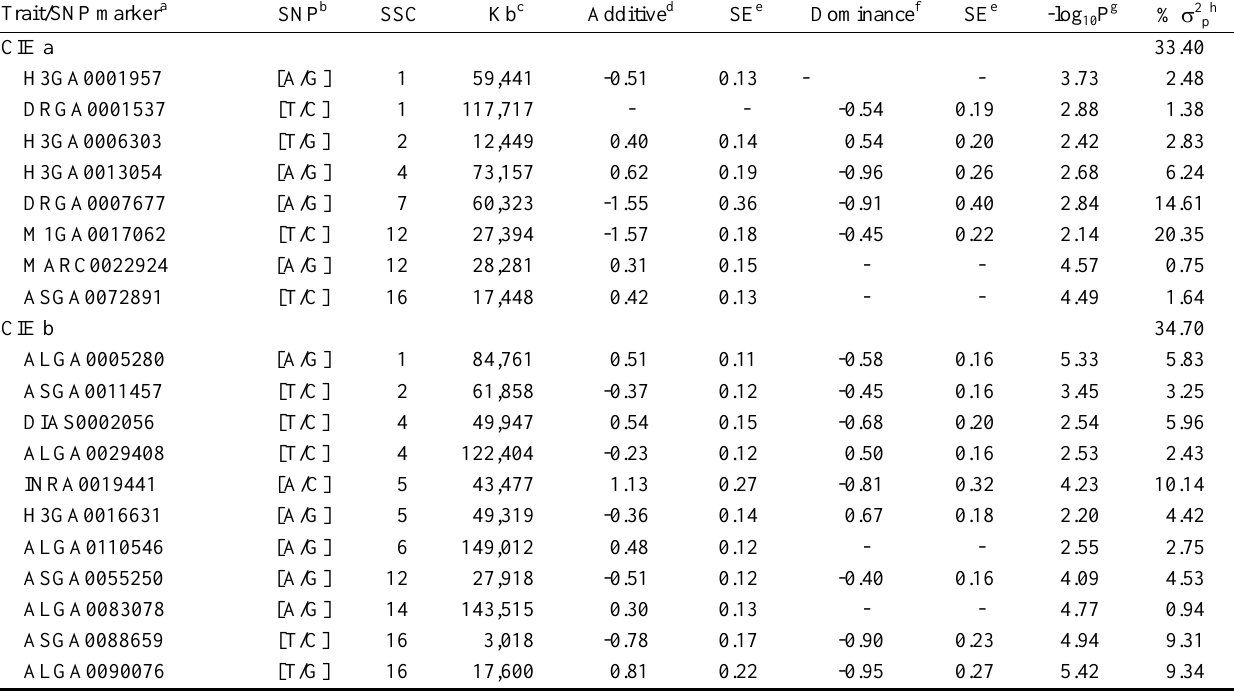
Table 3. Identities, positions of the SNPs with significant effects on meat quality traits in a Korean native pig and Landrace cross population (Continued) Trait/SNP marker